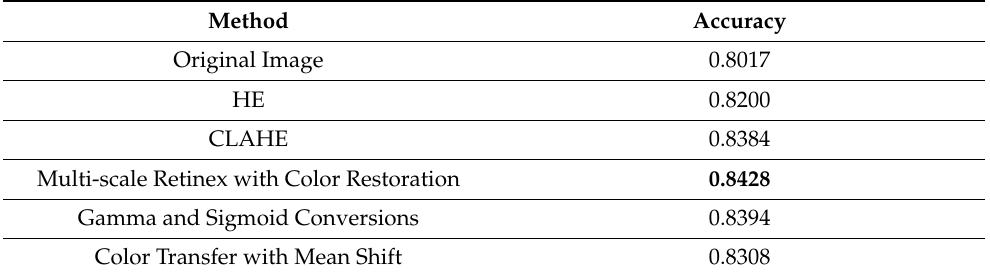
Table 7. Accuracy of the 3 color transfer methods in 2 polyp classes, HP and